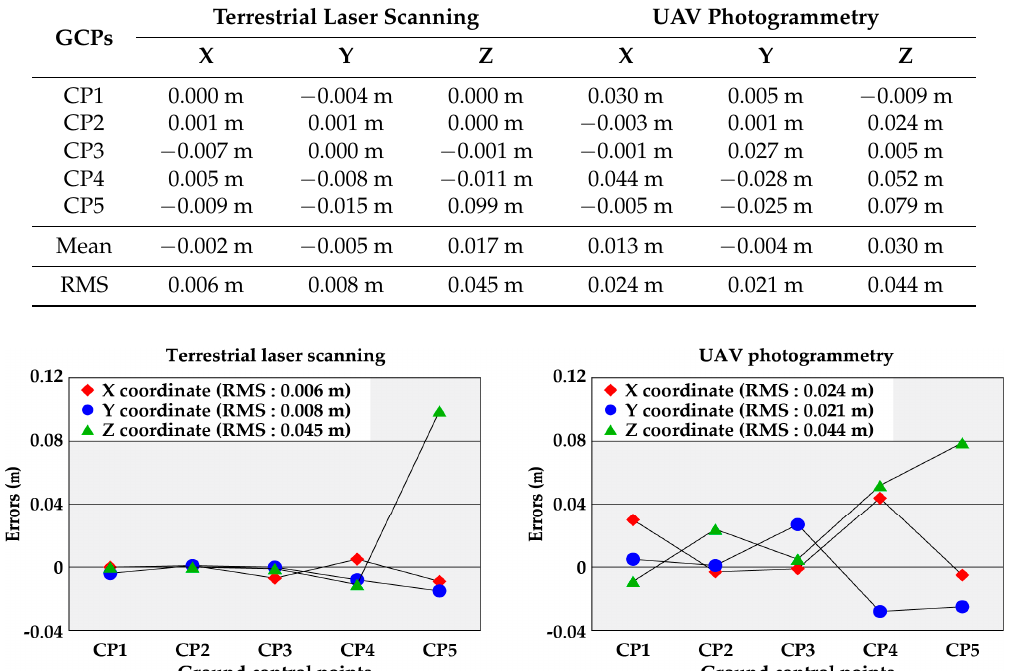
Figure 6. A total of 40 randomly selected points on the ground and buildings for analysis of the relative positional accuracy between terrestrial laser scanning and UAV photogrammetry. First, we compared the coordinate errors with the laser scanning and photogrammetry based on the five GCPs to evaluate the overall quality and absolute positional accuracy (Table 1, Figure 5). As a result, the X, Y, and Z coordinates of the laser scanning result deviated in the range − 0.009–0.005 m (RMS 0.006 m), − 0.015–0.001 m (RMS 0.008 m), and − 0.011–0.099 m (RMS 0.045 m), respectively. Additionally, the X, Y, and Z coordinates of the photogrammetry result exhibited discrepancies that